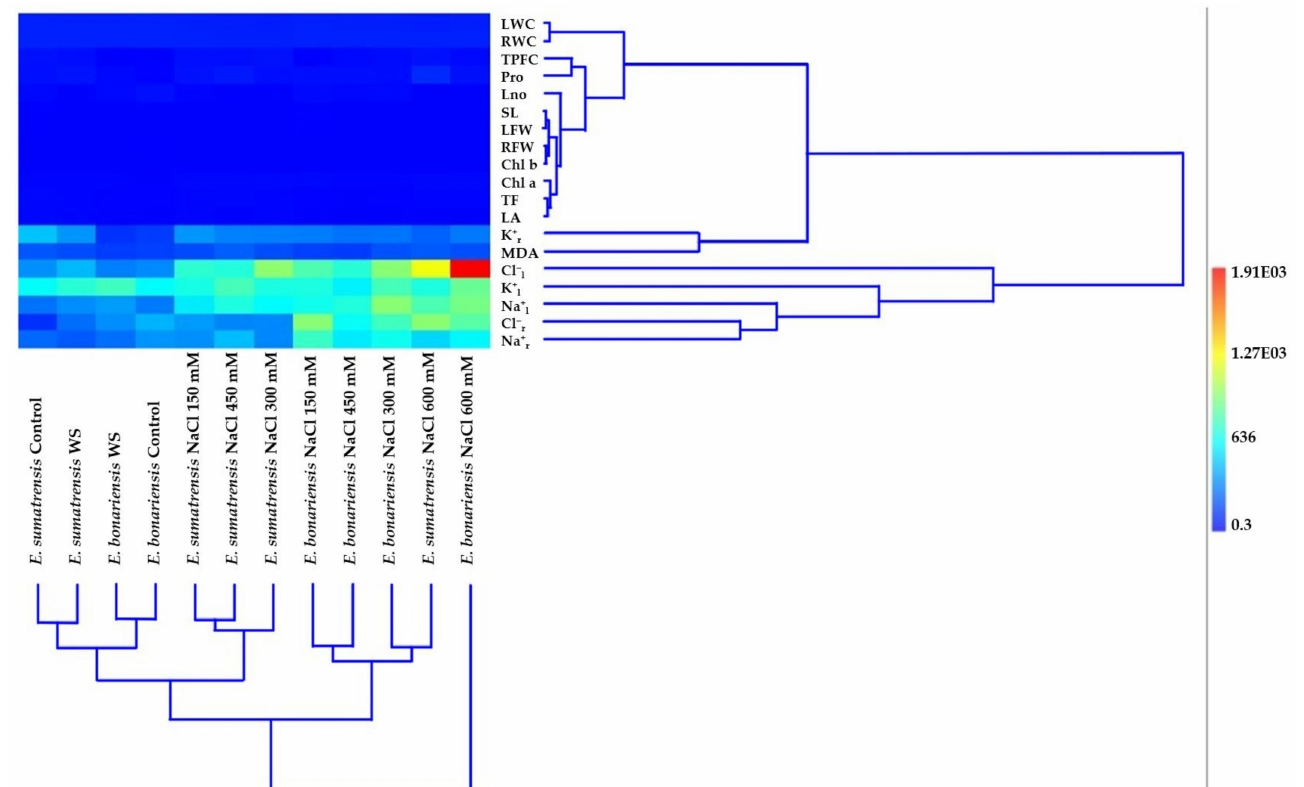
Figure 10. Multivariate analyses for the studied characteristics: Hierarchical clustering, algo- rithm Ward’s method, similarity index Euclidean of the two species of Erigeron (E. bonariensis and E. sumatrensis ). Abbreviations as in Figure